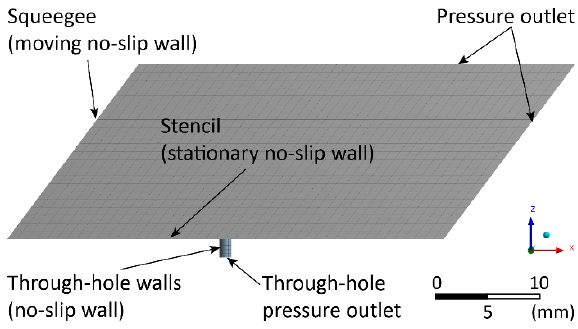
dynamic meshing method, using the bottom layering technique. The following boundary conditions were applied in the transient model: No-slip wall boundary conditions were applied at the stencil, the squeegee, and the sidewalls of the through-holes. The other walls possessed pressure outlet condition (Figure 3). walls possessed pressure outlet condition (Figure 3).